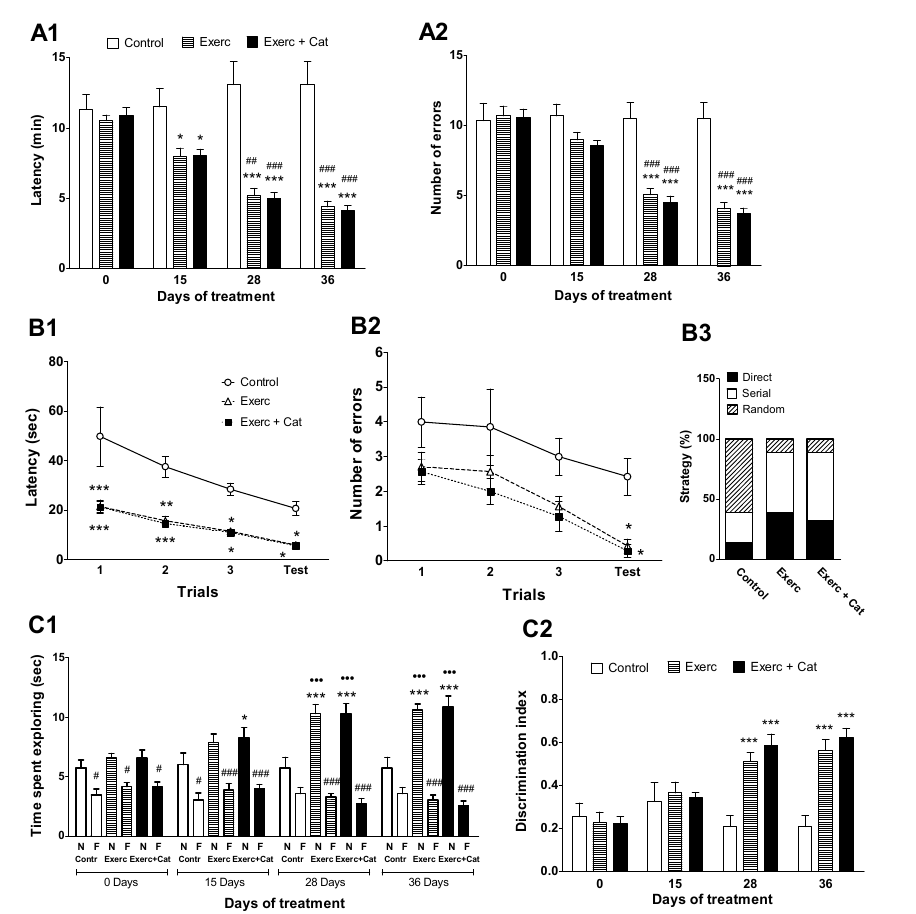
Figure 2. Effects of exercise and the combined action of exercise and catechin on behavioral tests. ( A ) Effect on spatial working memory using the radial maze test in old rats. Bars represent the mean ± SEM of time taken to complete the test ( A1 ) and errors made ( A2 ) of animals subjected to exercise (Exerc, n = 7) and exercise together with catechin antioxidant treatment (Exerc + Cat, n = 7) versus the control group ( n = 7). ( A1 ) Two-way repeated measures ANOVA detected a significant effect of treatment (F(2,72) = 14.6, p = 0.0002), age (F(3,72) = 30.5, p < 0.0001), subjects (F(18,72) = 9.26, p < 0.0001) and the interaction (F(6,72) = 18.5, p < 0.0001). ( A2 ) Two-way repeated measures ANOVA detected a significant effect of treatment (F(2,72) = 10.1, p = 0.0012), age (F(3,72) = 60.9, p < 0.0001), subjects (F(18,72) = 7.22, p < 0.0001) and the interaction (F(6,72) = 15.5, p < 0.0001). ( B ) Effect on visuospatial learning ability using the Barnes maze test in old rats. Dots represent the mean ± SEM of latency ( B1 ) and errors made ( B2 ) throughout the Barnes test of the same groups as A. The bars represent the average of the strategy followed in % with respect to the total sum of the 3 training and test stages ( B3 ) of the animals. ( B1 ) Two-way ANOVA repeated measures detected a significant effect of treatment (F(2,72) = 21.3, p < 0.0001), trial (F(3,72) = 17, p < 0.0001) and subjects (F(18,72) = 2.09, p = 0.0191), but not for the interaction (F(6,72) = 0.938, p = 0.4759). ( B2 ) Two-way ANOVA repeated measures detected a significant effect of treatment (F(2,72) = 10.6, p = 0.0009) and trial F(3,72) = 10.1, p < 0.0001), but not for the subjects (F(6,72) = 1.38, p = 0.1820) or the interaction (F(6,72) = 0.161, p = 0.9859). ** p < 0.001 comparing with the control group; ## p < 0.01, ### p < 0.001 comparing the values obtained before and after performing the treatments in each group (two-way ANOVA, followed by Bonferroni test). ( C ) Effect on episodic memory using the novel object recognition test in old rats. Bars represent the mean ± SEM of the total time spent exploring for each object (N, novel object; F, familiar object) in the test phase ( C1 ), as well as the discrimination index between the novel and familiar object in the test phase ( C2 ) of same groups of animals. ( C1 ) Three-way ANOVA detected a significant effect of treatment (F(2,144) = 17.179, p = 0.0327), age (F(3,144) = 2.999, p < 0.0001) and objects (F(1,144) = 296.749, p < 0.0001). ( C2 ) Two-way ANOVA repeated measures detected a significant effect of treatment (F(2,72) = 8.77, p = 0.0022), age (F(3,72) = 16.8, p < 0.0001), subjects (F(18,72) = 2.68, p = 0.0027) and interaction (F(6,72) = 8.14, p < 0.0001). * p < 0.05, *** p < 0.001 when compared to the control group; # p < 0.05, ### p < 0.001 comparing the exploration time between the novel object and the familiar object; ••• p < 0.001 when comparing the values obtained before and after performing the treatments in each group ( C1 : three-way ANOVA, followed by Fisher PLSD test; C2 : two-way ANOVA, followed by Bonferroni